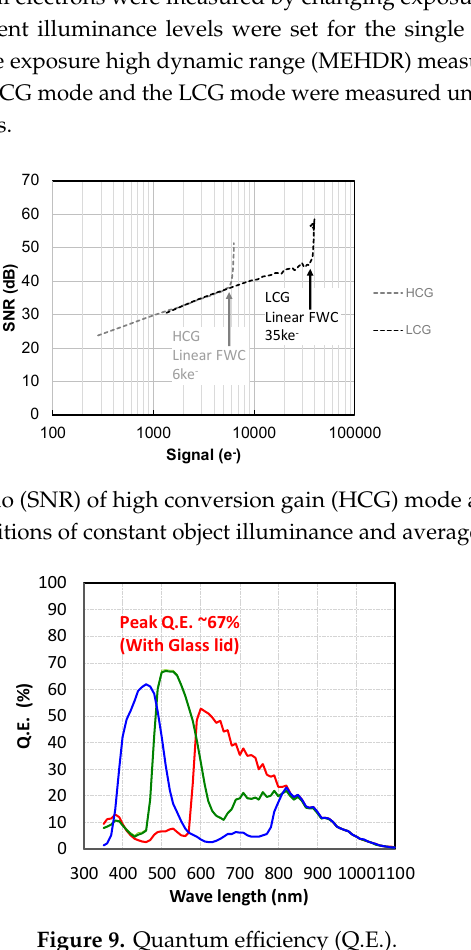
Figure 9. Quantum efficiency (Q.E.).